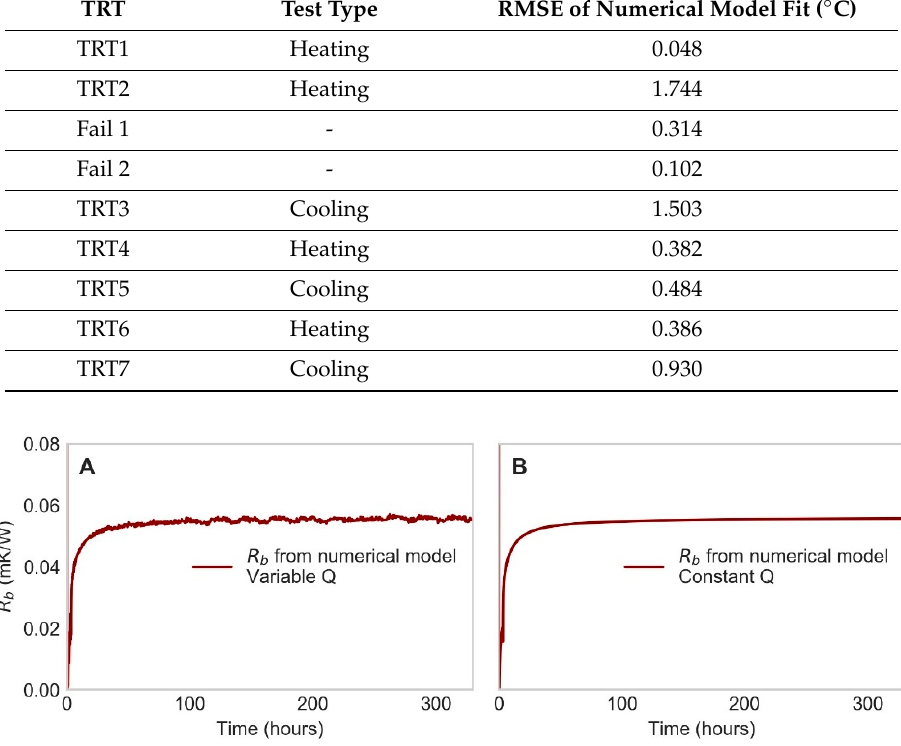
Figure 7. Pile thermal resistance ( R b ) from simulations: ( A ) parameter estimation best fit, and ( B ) synthetic TRT data for best fit model simulation with constant power based on average of measured data.